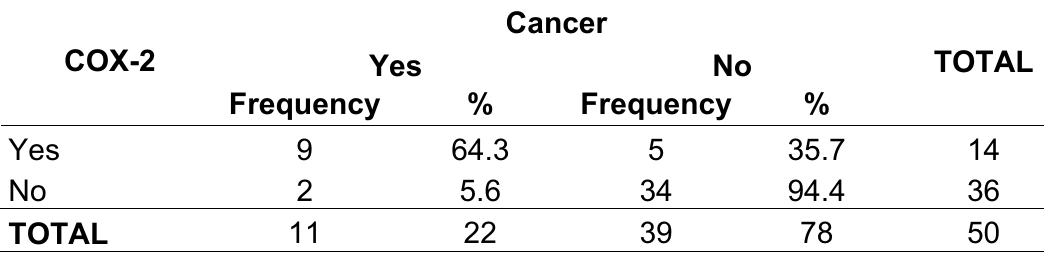
Fisher’s exact test, p=0.000034*; Odds Ratio: 27.29 (4.99 – 230.94); RR: 11.57 (2.84 –